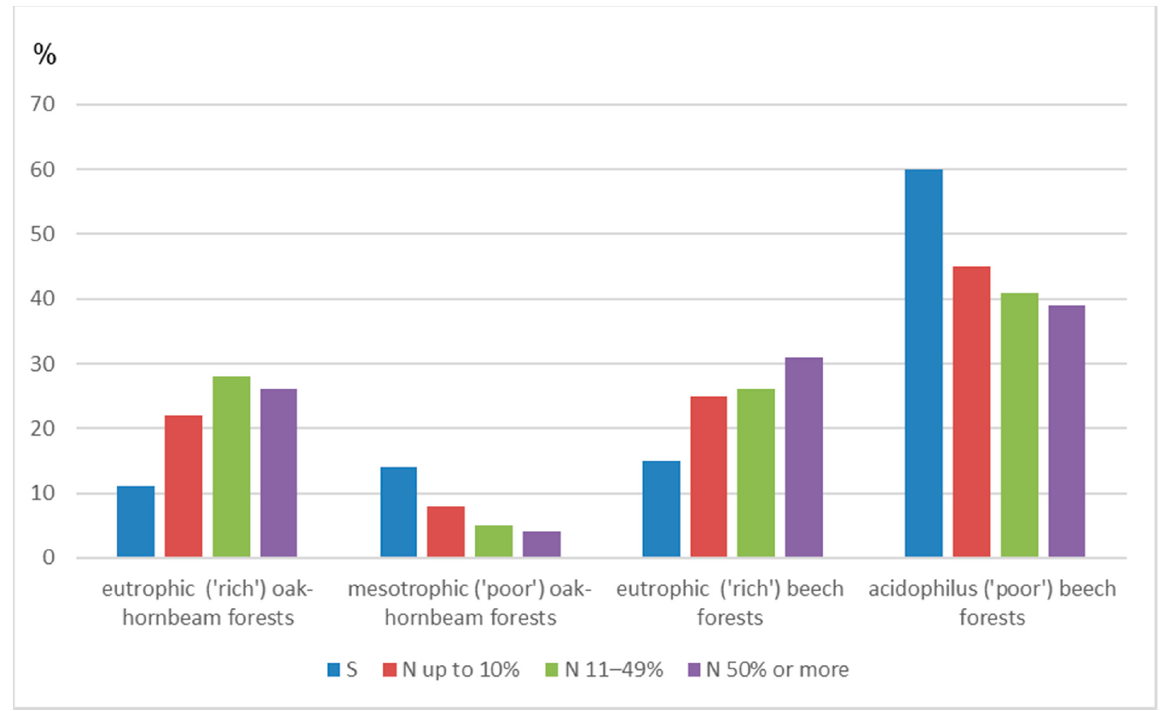
Figure 2. Comparison of the percentage distributions of the surface area (S) most important groups of potential natural vegetation (in the area covered by the study) and the percentage distributions of the total fir localities numbers (N).